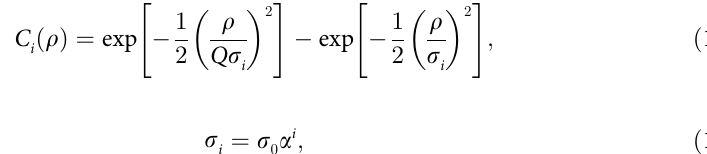
PLOS ONE | https://doi.org/10.1371/journal.pone.0229915 March 12,